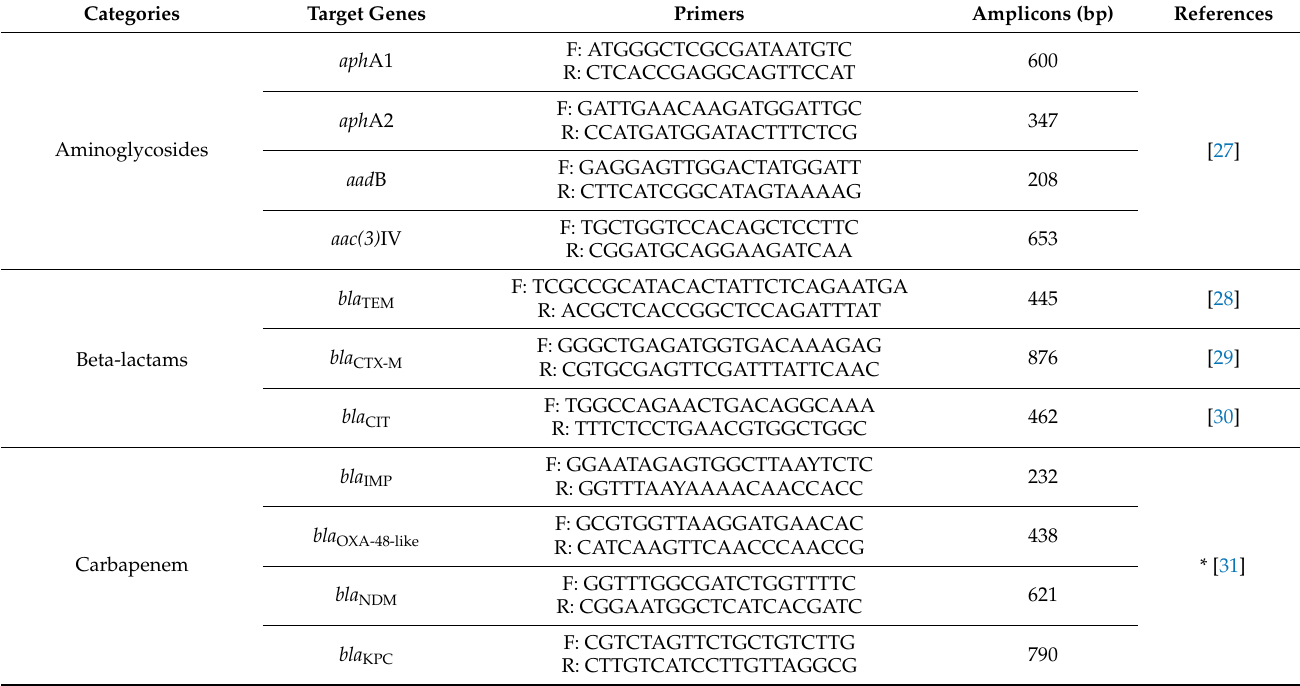
Table 2. Target genes used for ARG screening in the present